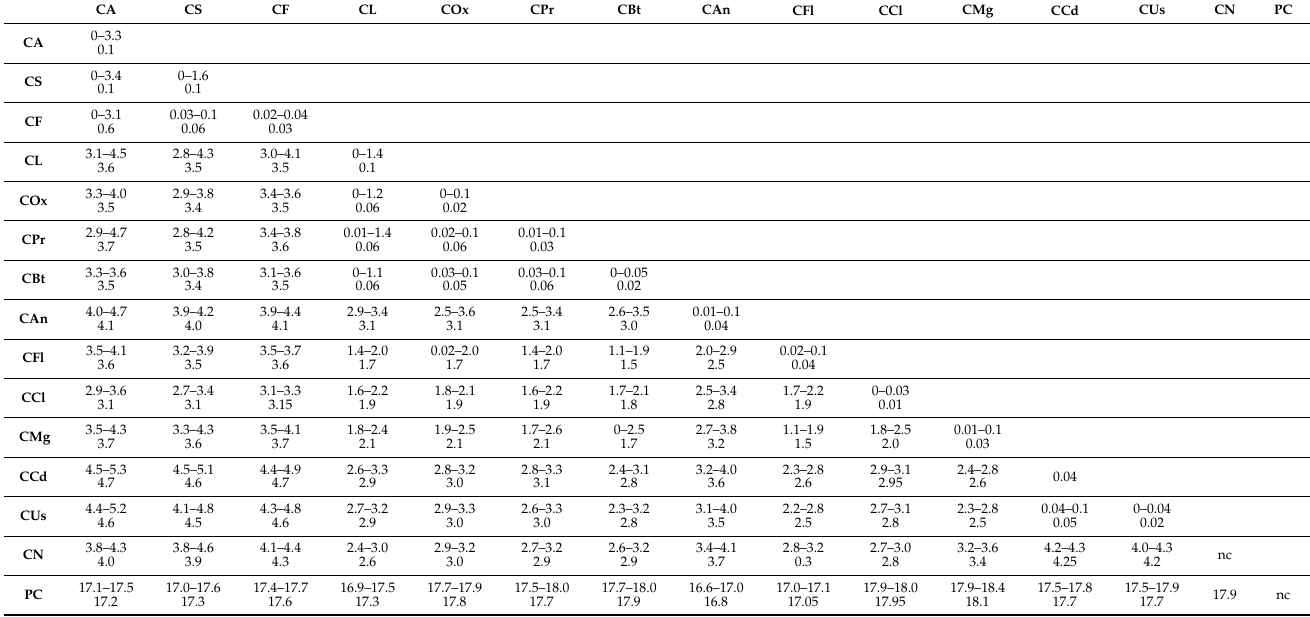
Table 3. Inter- and intraspecies p -distance values (as %) for coregonid species; minimum, maximum, and mean values are